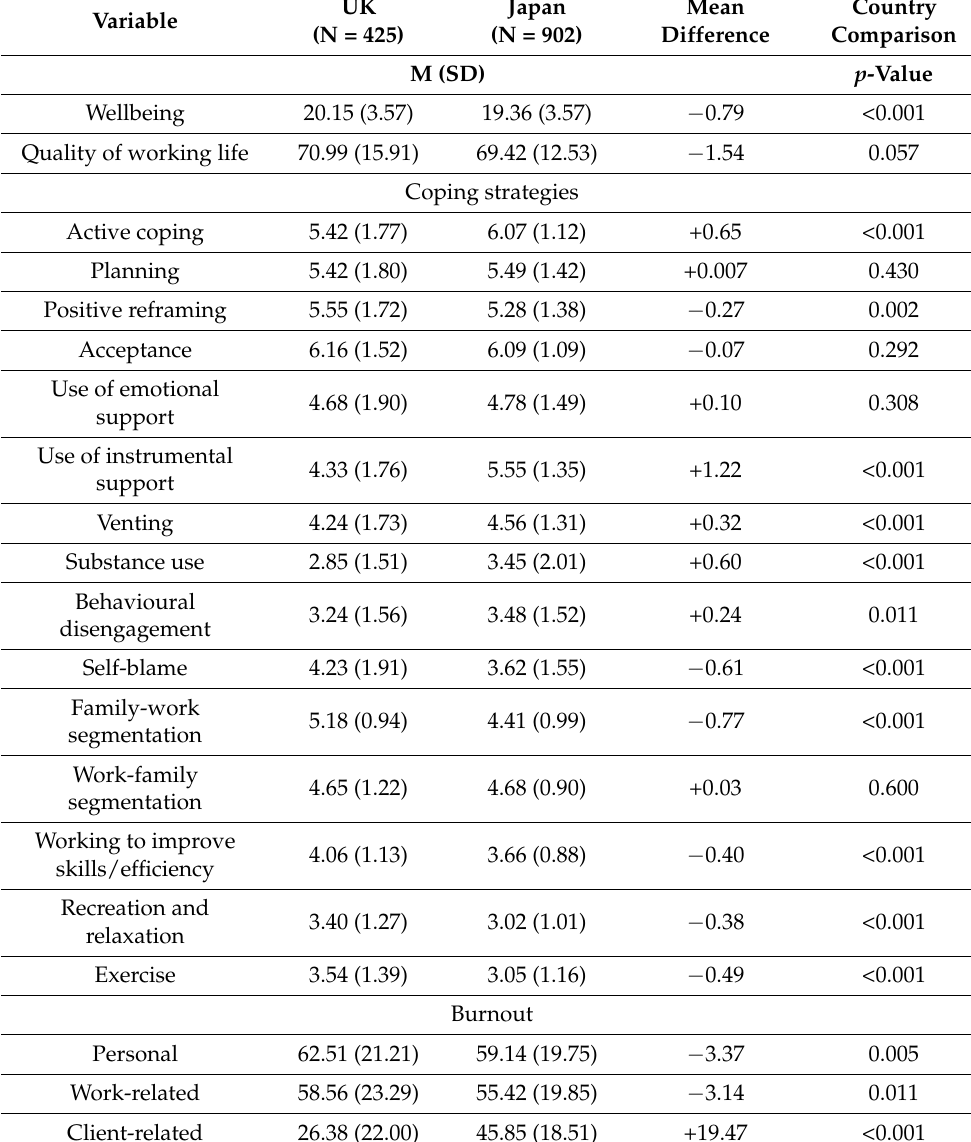
Table 2. Means and standard deviations (in brackets) for Wellbeing, Work-Related Quality of Life (WRQoL), Coping strategies and Burnout across the two countries. UK Japan Mean Country Variable (N = 425) (N = 902) Difference